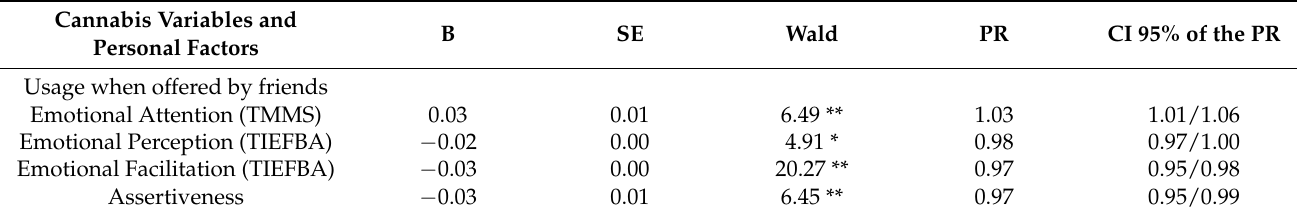
Table 7. Binomial regression analysis based on the 14–16 years age